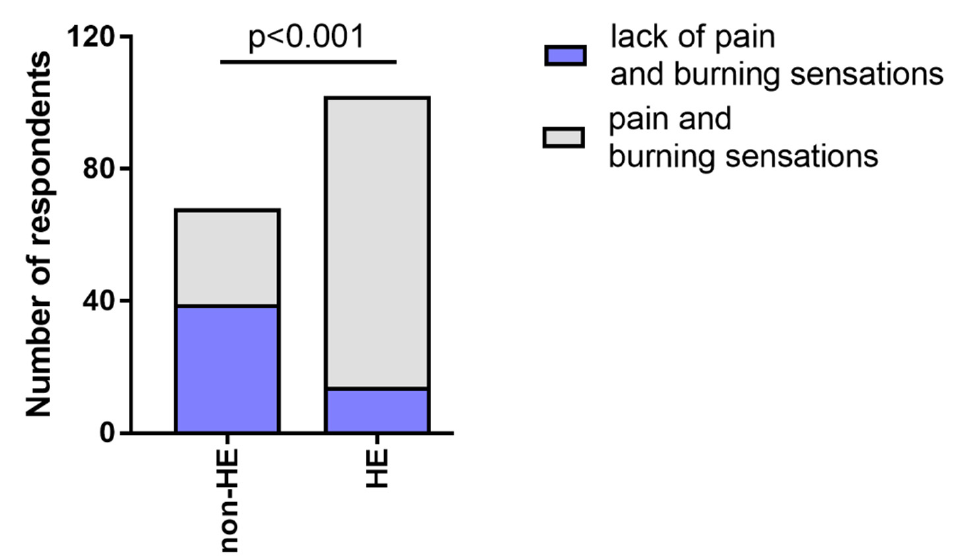
Figure 9. The frequency of pain and burning sensations after using disinfectants in both groups. The frequency of pain and burning sensations was significantly higher in the HE-study group compared to the non-HE group, HE-n/derm to non-HE, and HE-derm to non-HE ( p < 0.001, p < 0.0001, p < 0.0001, respectively). There was no significant difference etween HE-n/derm and HE-derm with regard to the frequency of pain and burning sensations in these study groups (Figure